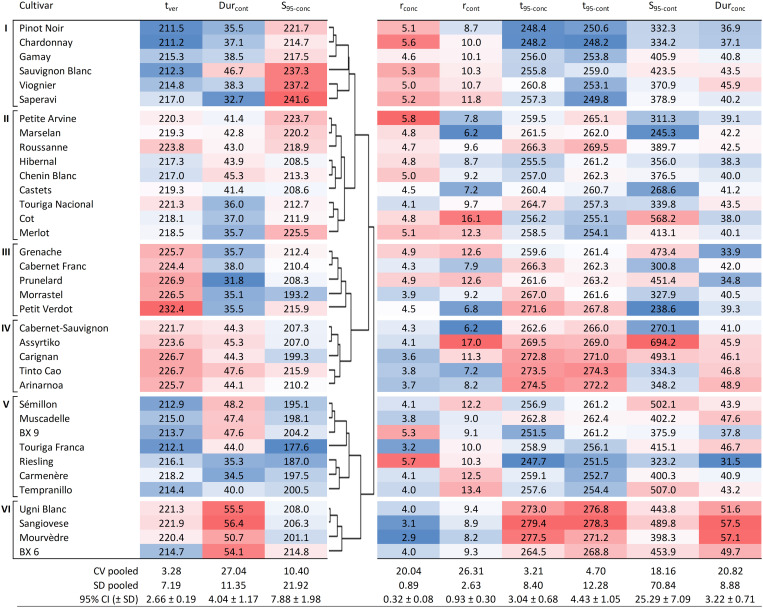
Hierarchical cluster analysis based on tver, Durcont, and S95–conc, showing six groups for the 36 cultivars together with other sugar accumulation traits for reference. Values shown are averages of each trait for each cultivar (over 7 years and four blocks, n = 28). Blue cells are increasingly lower values and red cells are increasingly higher values within the range observed for each of the traits. DOY, day of the year; CV pooled, pooled coefficient of variation; SD pooled, pooled standard deviation; 95% CI, average 95% confidence interval with standard deviation.